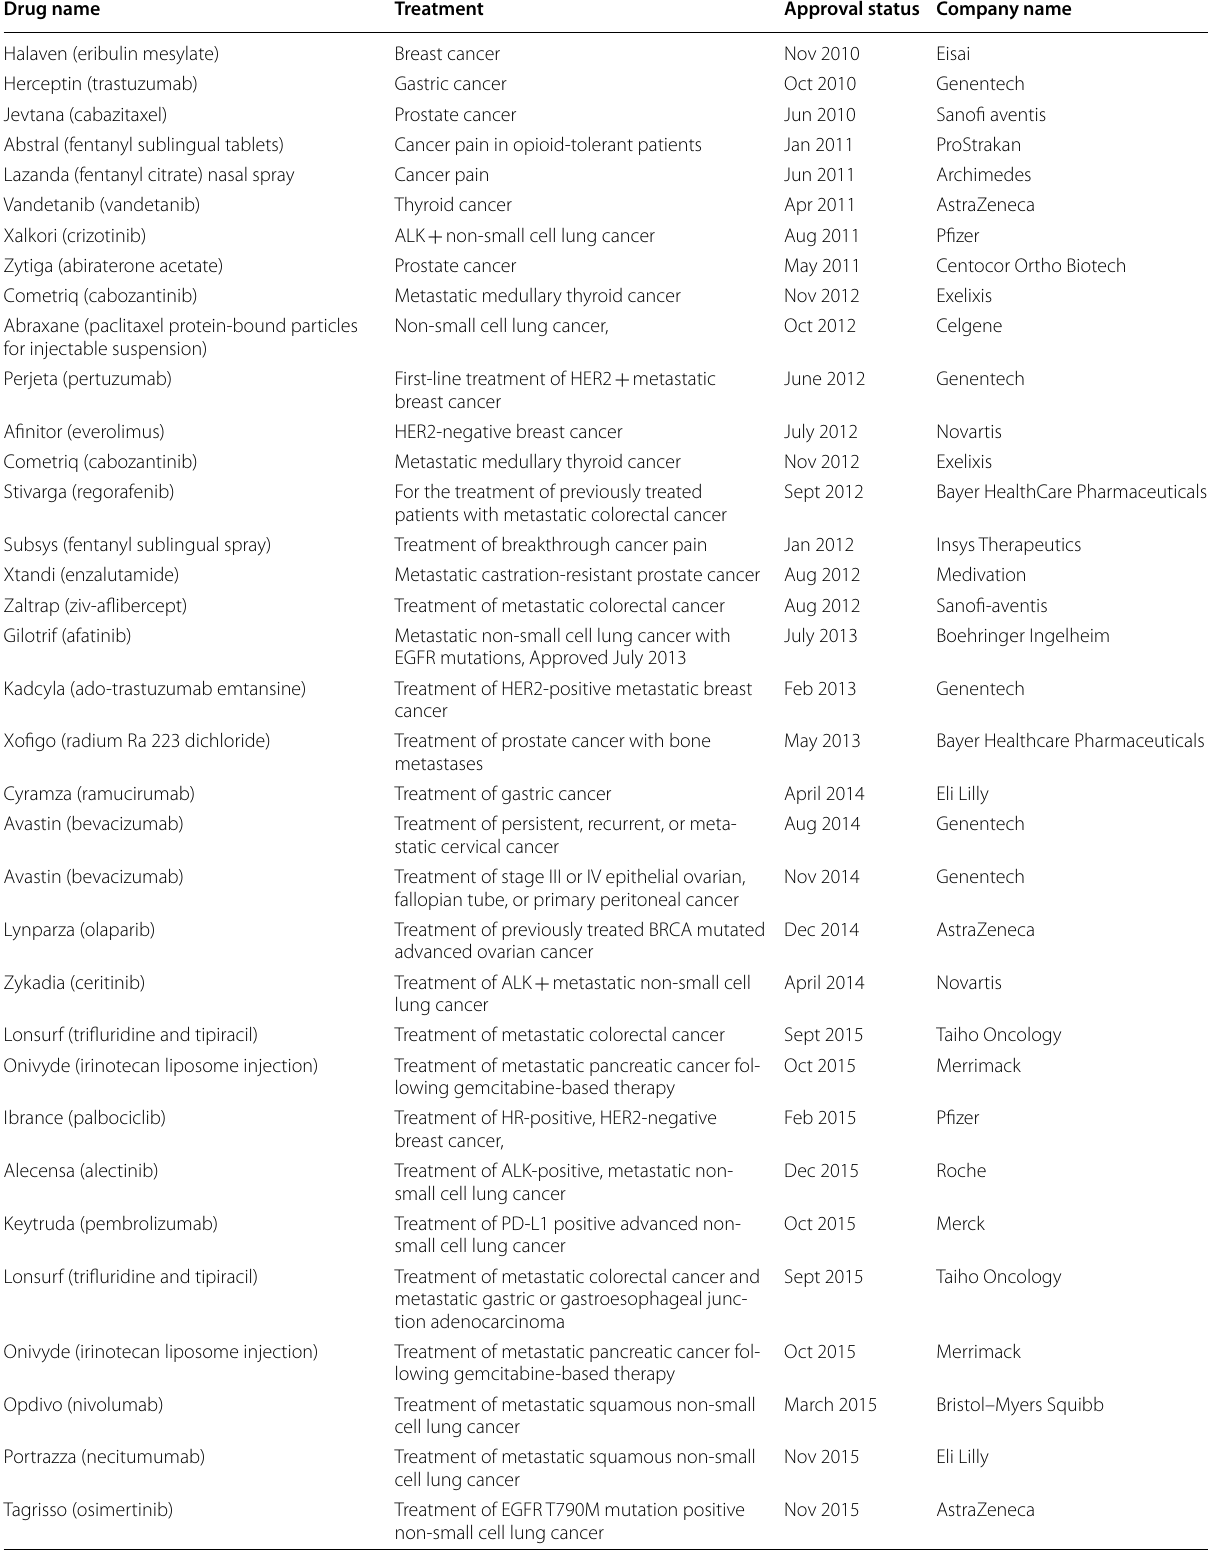
Table 1 FDA approved cancer drugs from 2010 to 2020 Drug